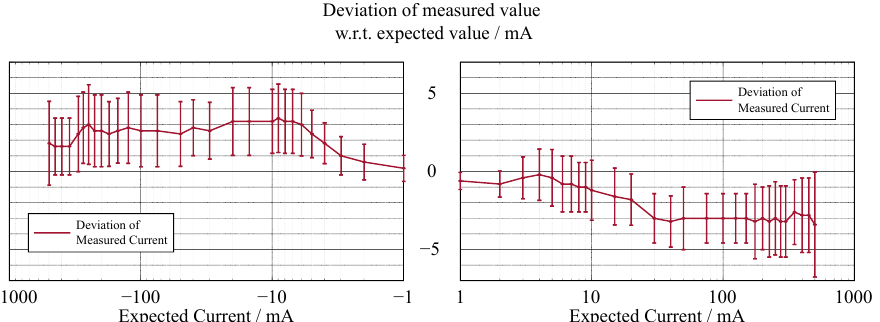
Figure 5. Absolute deviation of the current as measured by the sensor box with regard to the expected value.